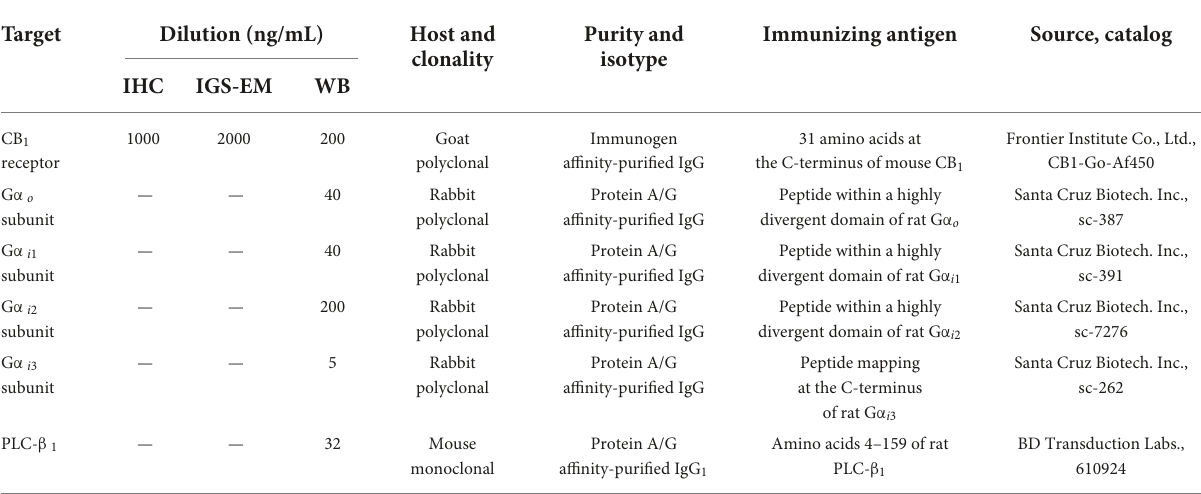
Purity and Immunizing clonality isotype